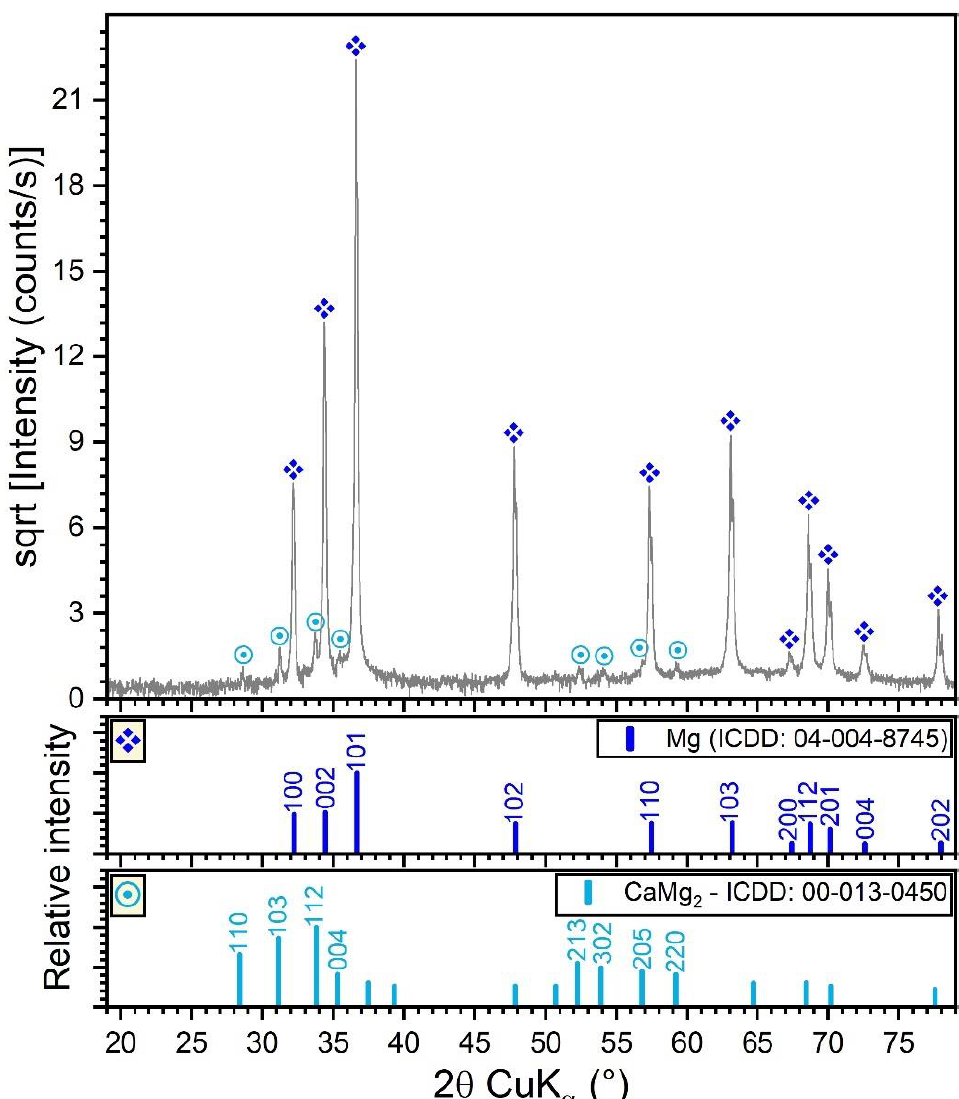
Figure 3. XRD diagram (collected in Bragg – Brentano geometry) of the Mg-0.8Ca alloy.